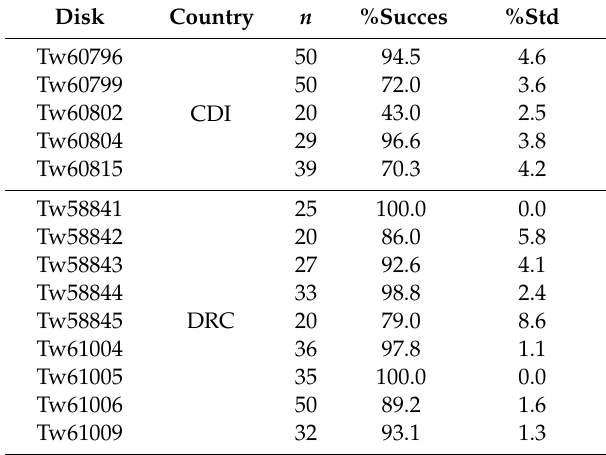
Table 2. Country classification per disk for Terminalia superba . The samples of the given disk are excluded in the training set. The number of samples per disk ( n ), the average prediction success (%success) and standard deviation (%std) across the five random forest runs are given. Disk Country n %Succes %Std Tw60796 CDI